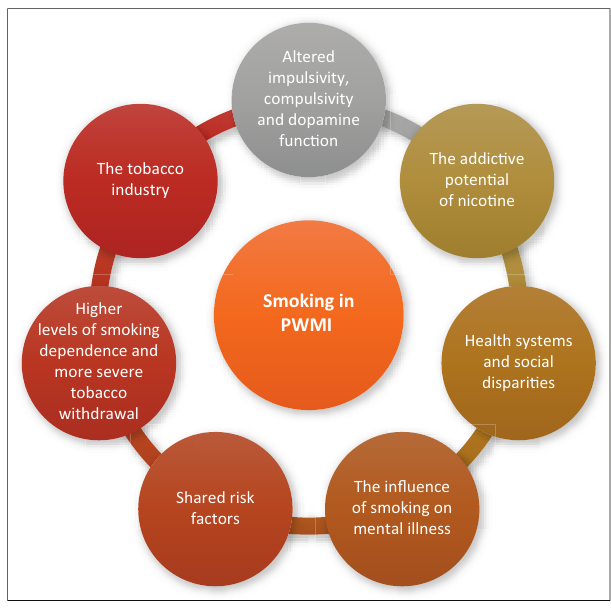
FIGURE 1: Factors influencing the relationship between mental illness and